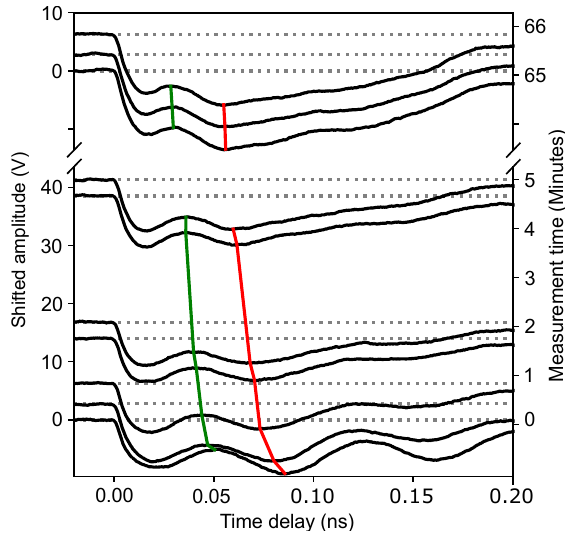
Figure 7. Irreversibility of the curing process demonstrated by the measurements of the acoustically induced transient optical reflectivity ∆ R / R accompanied by the interruption of the experiments for 1 h after the first 5 min of the measurements. The green and red lines, passing through the maxima and minima of the first Brillouin oscillation, indicate a continuous diminishing of the Brillouin frequency with increasing experimental time. No increase in the Brillouin frequency was observed during the time when the experiment was stopped.